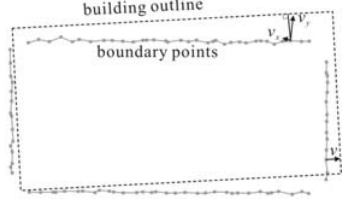
Figure 2. Boundary points and ridge